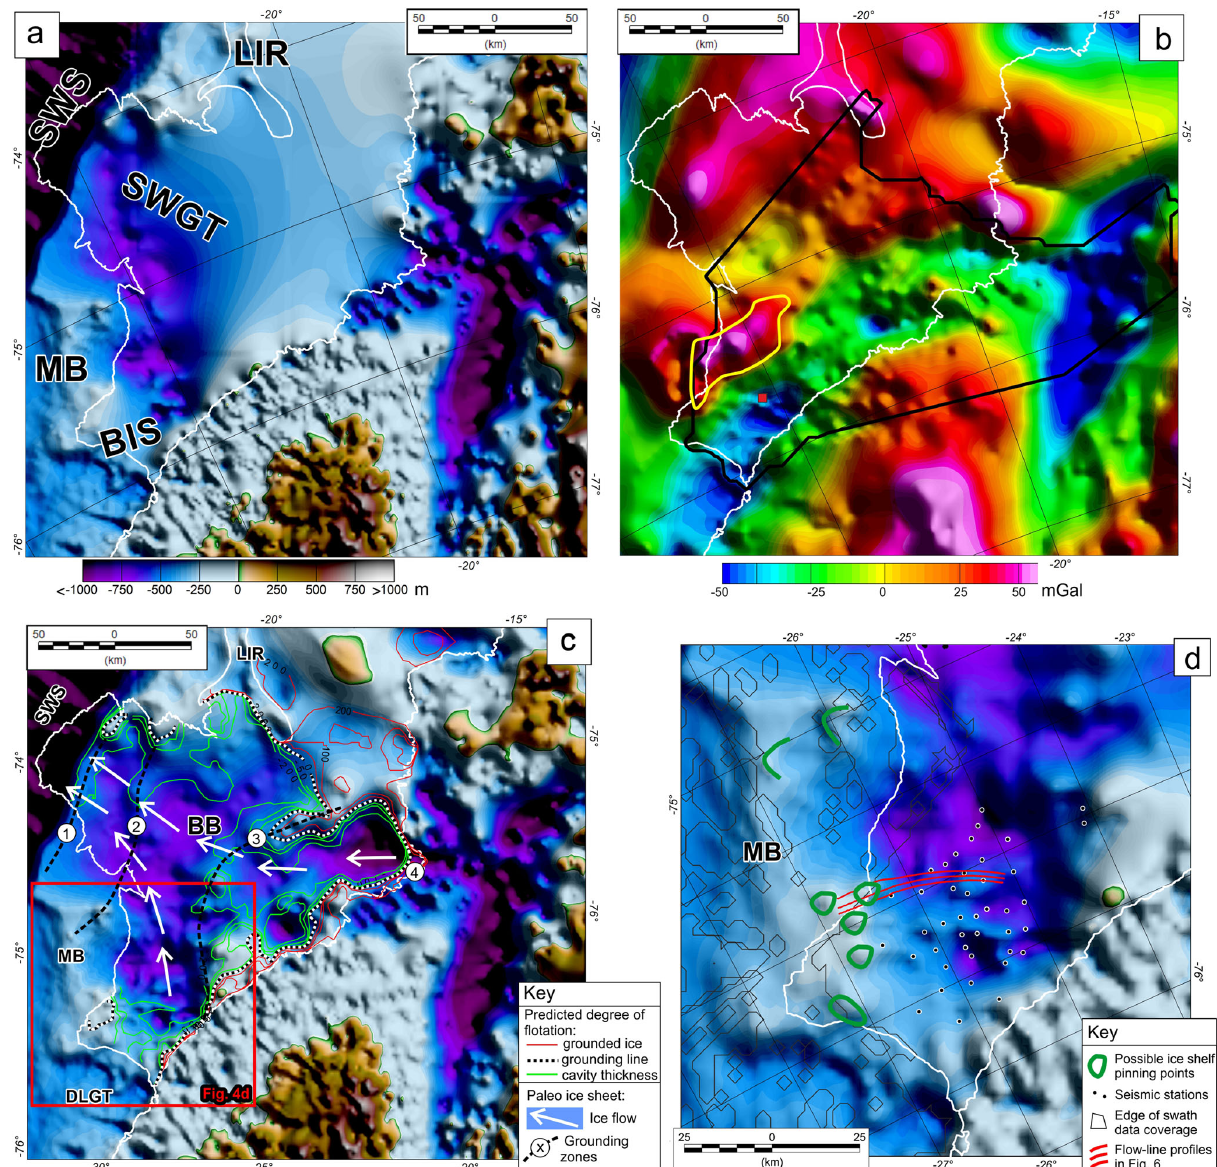
Figure 4. Revised topography beneath the Brunt Ice Shelf and Stancomb-Wills Glacier Tongue. (a) Topography derived from direct obser- vations including swath bathymetry offshore and in areas historically accessible to ships during past calving events, seismic depth sounding of the ice shelf, and radar depth sounding over the grounded ice sheet. (b) Free-air gravity anomalies. Data inside black outline from new strapdown gravity data set (Becker et al., 2018). Regional data from the ICEGRAV 2013 survey (Forsberg et al., 2017) and previous regional compilations (Jordan et al., 2017). Note gravity “high” outlined in yellow attributed to a large mafic intrusion based on gravity and magnetic signatures (Jordan and Becker, 2018). (c) Integrated bathymetric model including additional constraints from gravity data beneath the ice shelf. Black and white contour is the predicted grounding line. Red contours show areas predicted to be grounded by ice 50, 100, or 200m deeper than the calculated bed. Green contours show 50, 100, and 200m predicted cavity thicknesses. Probable orientations of past grounded ice flow are indicated by white arrows. Inferred former grounding lines based on mapped topographic highs are marked by numbered black dashed lines (1–3) together with the current grounding line (4). (d) Details of the topography beneath the Brunt Ice Shelf. Red lines mark the position of flow lines plotted in Fig. 6. Black dots show seismic stations and thin black lines mark edges of swath bathymetric data coverage. Green circles and crescent-shaped lines indicate possible past and present pinning points. Abbreviations are LIR (Lyddan Ice Rise), SWS (southern Weddell Sea), MB (McDonald Bank), SWGT (Stancomb-Wills Glacier Tongue), BIS (Brunt Ice Shelf), BB (Brunt Basin), and DLGT (Dawson-Lambton Glacier